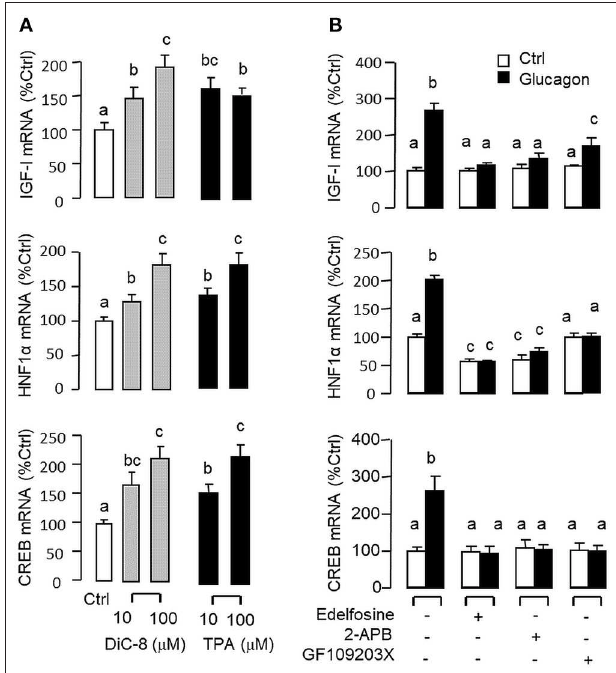
FIGURE 5 | Functional role of the PLC/IP 3 /PKC pathway in glucagon-induced IGF-I, HNF1 α , and CREB transcript expression at the hepatic level. Effects of increasing functional levels of DAG using the DAG analog DiC-8 (10–100nM) or stimulating PKC activity using the PKC activator TPA (10–100M) on IGF-I, HNF1 α , and CREB mRNA expression in carp hepatocytes (A) . In parallel experiments, glucagon treatment (10nM) was also tested in the presence of the PLC inhibitor Edelfosine (20 µ M), IP 3 receptor blocker 2-APB (100 µ M) or PKC inactivator GF109203X (10 µ M) (B) . In these studies, the duration of drug treatment was fixed at 12h. After that, total RNA was isolated from individual wells and used for real-time PCR with primers for IGF-I, HNF1 α , and CREB, respectively.